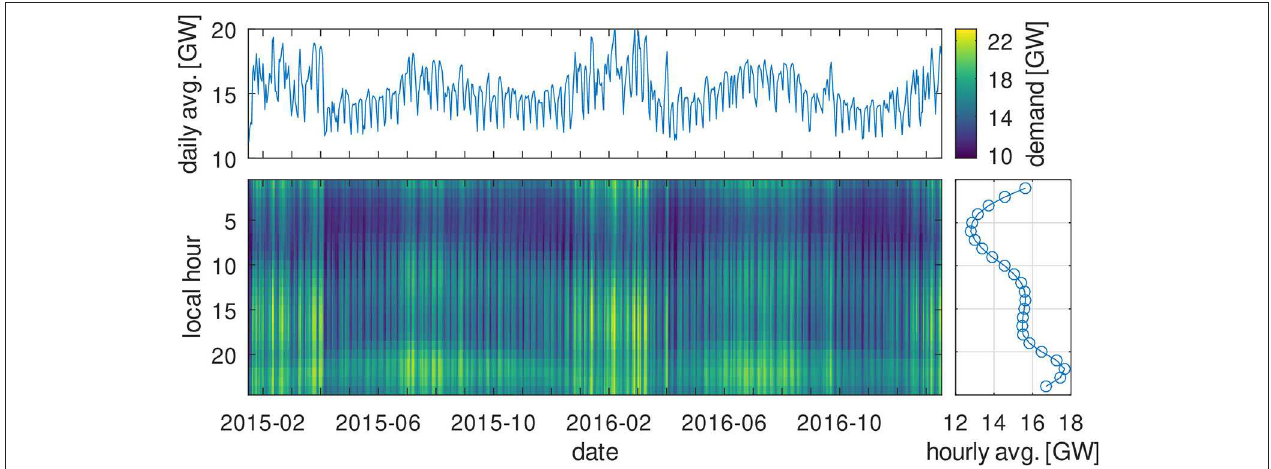
FIGURE 3 | Electricity load from 2015 to 2016, provided by the national grid administrator. Average electricity load is 15.1GW, with peaks of 23GW, and valleys of 9.6GW.